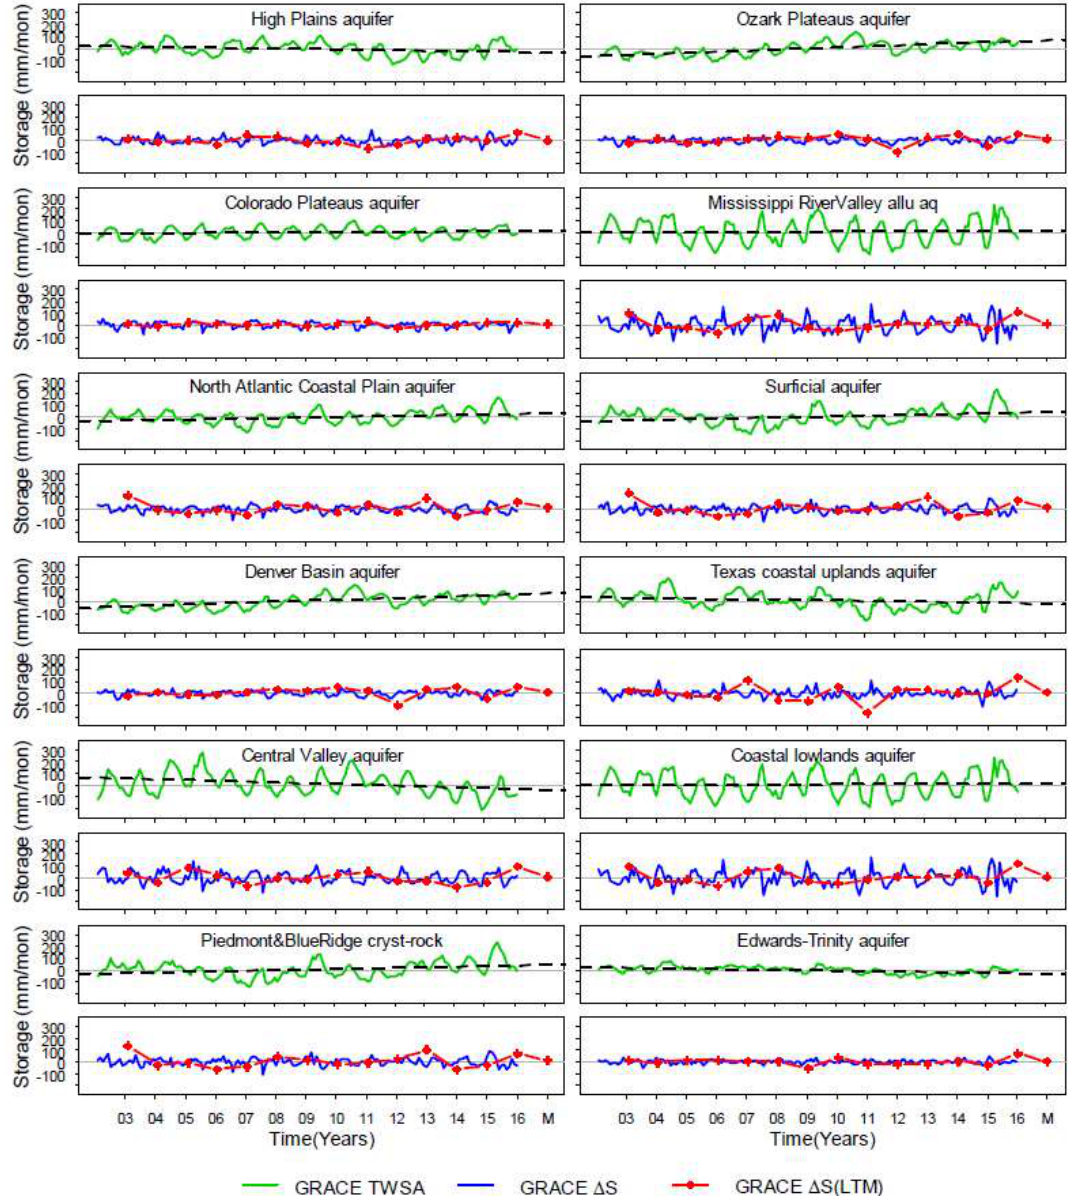
Figure 3. Time-series plots of monthly GRACE TWSA for the principal aquifers in CONUS during 2003–2016. Dashed lines indicate the slope and decadal trend. LTM stands for long term for annual ( ∆ S ANN ) and decadal ( ∆ S DM ) change in storage. The “M” in x-axis represents a decadal time scale. Table 1. Analysis of the ratio of month-to-month change in storage and P (ΔS/P) annual max, min, and decadal mean (DM) for each region to understand the significance of change in storage in the water budget.